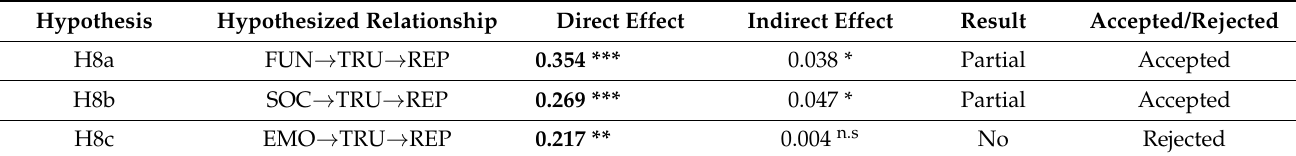
Table 5. Results of Mediation Analysis.